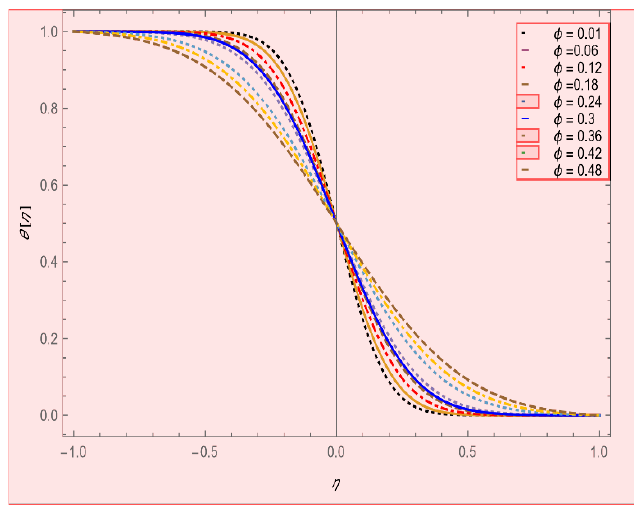
Figure 5. Concentration profiles for 𝜑 1 = 𝜑 2 = 0.01, 𝛼 = −1, 𝑀 = 1, 𝑆𝑐 = 1, 𝑃𝑟 = 6.2.